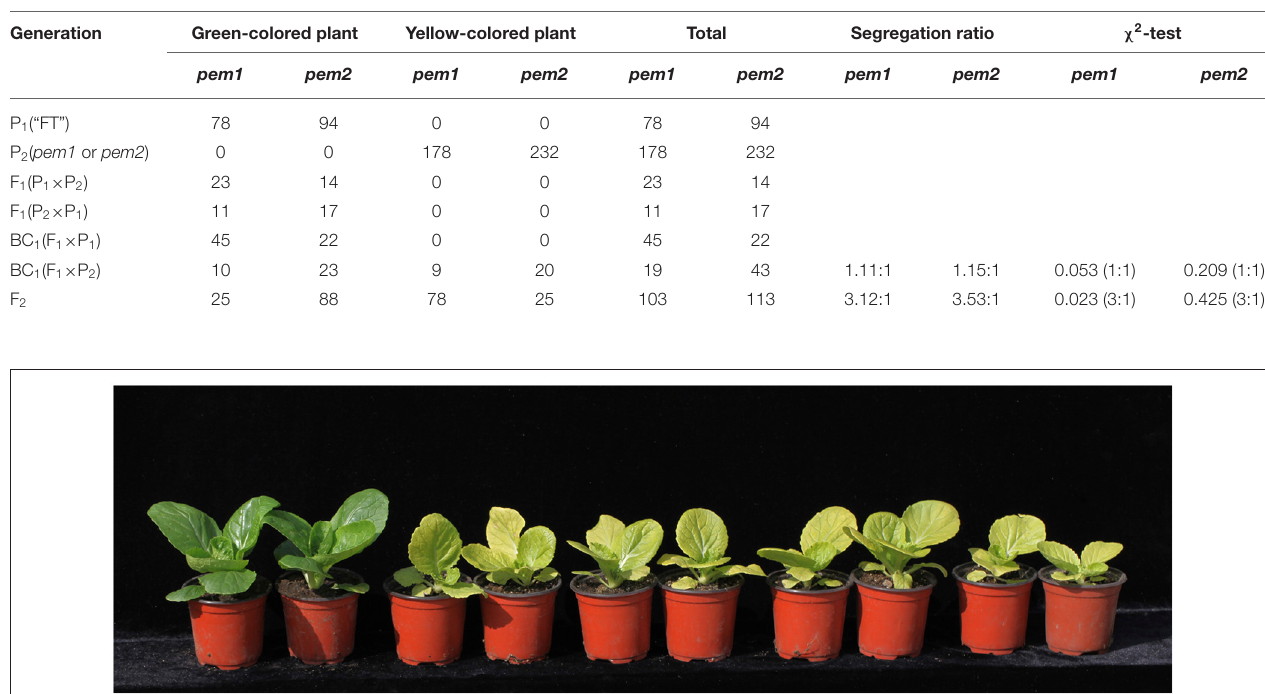
FIGURE 3 | Morphological appearance of allele mutant lines ( pem1 and pem2 ). Left to right : 1 and 2, “FT”; 3 and 4, pem1 ; 5 and 6, pem1 × pem 2 ; 7 and 8, pem2 × pem1 ; 9 and 10, pem2 .